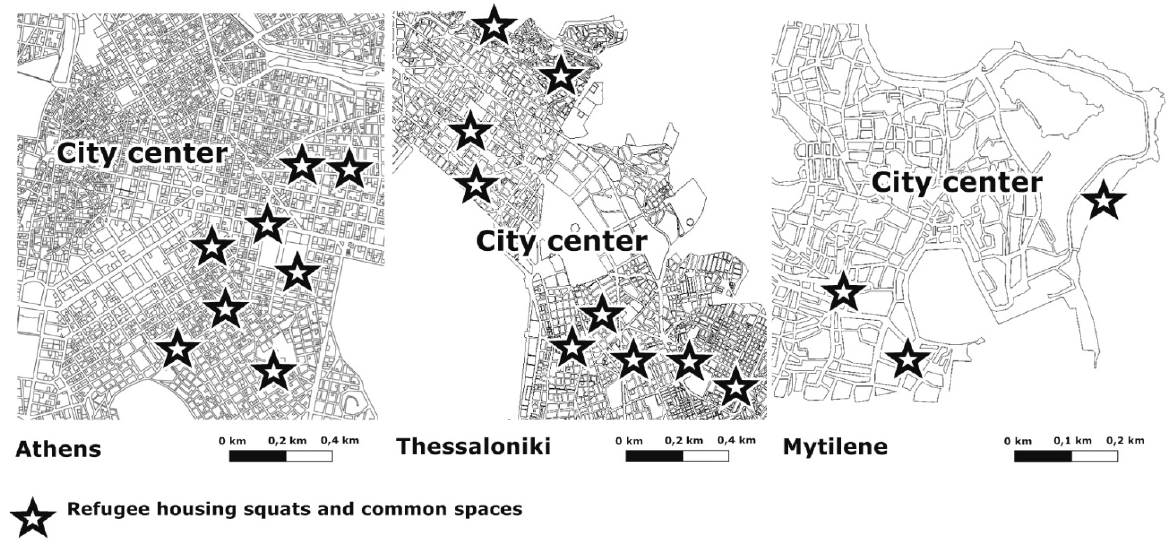
Figure 2. Refugee housing squats and common spaces in Athens, Thessaloniki, and Mytilene, 2016–2017. Source: